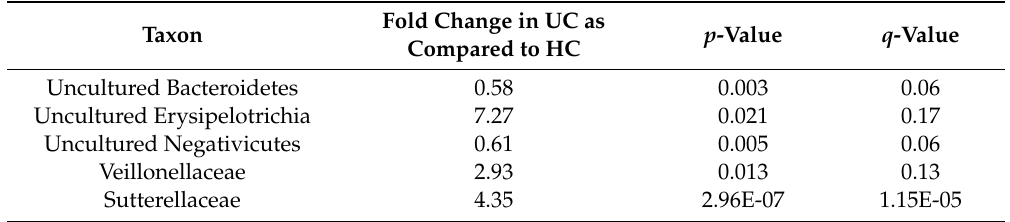
Table 2. Family-level microbiota di ff erence between ulcerative colitis (UC) patients and controls. Fold Change in UC as p -Value q Taxon Compared to HC